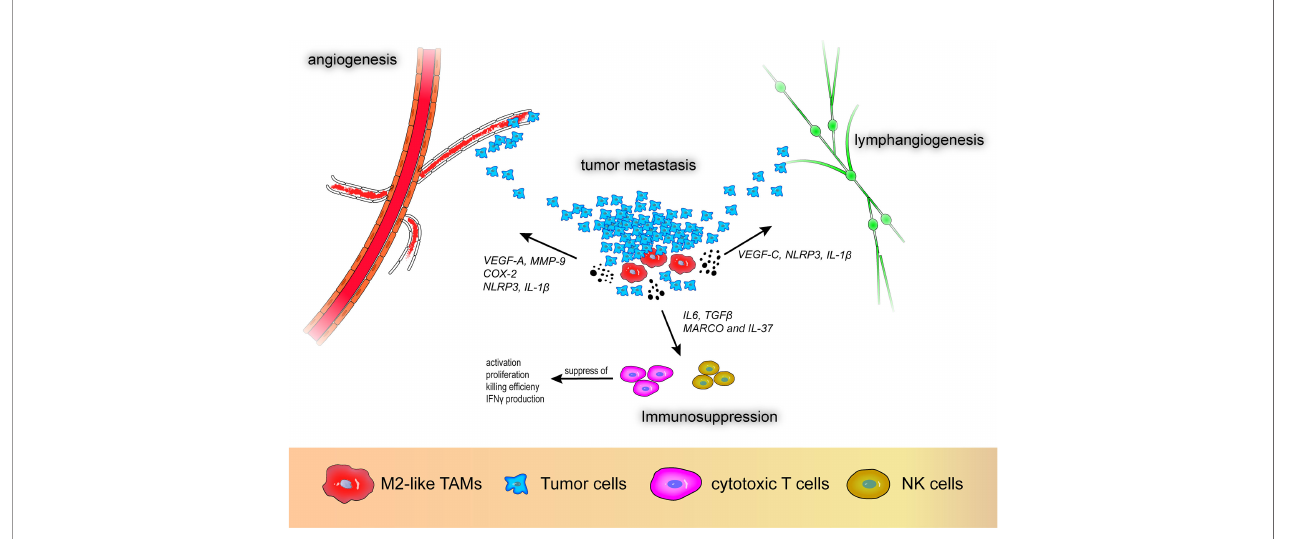
FIGURE 2 | M2-like tumor-associated macrophages promote angiogenesis, lymphangiogenesis, immunosuppression, and tumor metastasis. VEGF-A, vascular endothelial growth factor A; VEGF-C, vascular endothelial growth factor C; MMP-9, matrix metalloproteinase 9; COX-2, cyclooxygenase-2; MARCO, macrophage receptor with collagenous structure; NLRP3, nod-like receptor protein